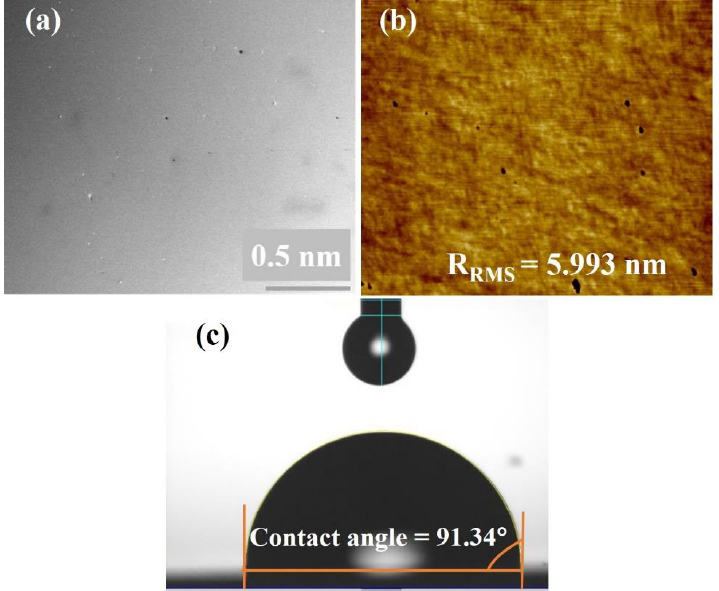
Figure 1. ( a ) FIB-SEM image; ( b ) AFM image; and ( c ) water dropped on the non-irradiated GaAs sample.